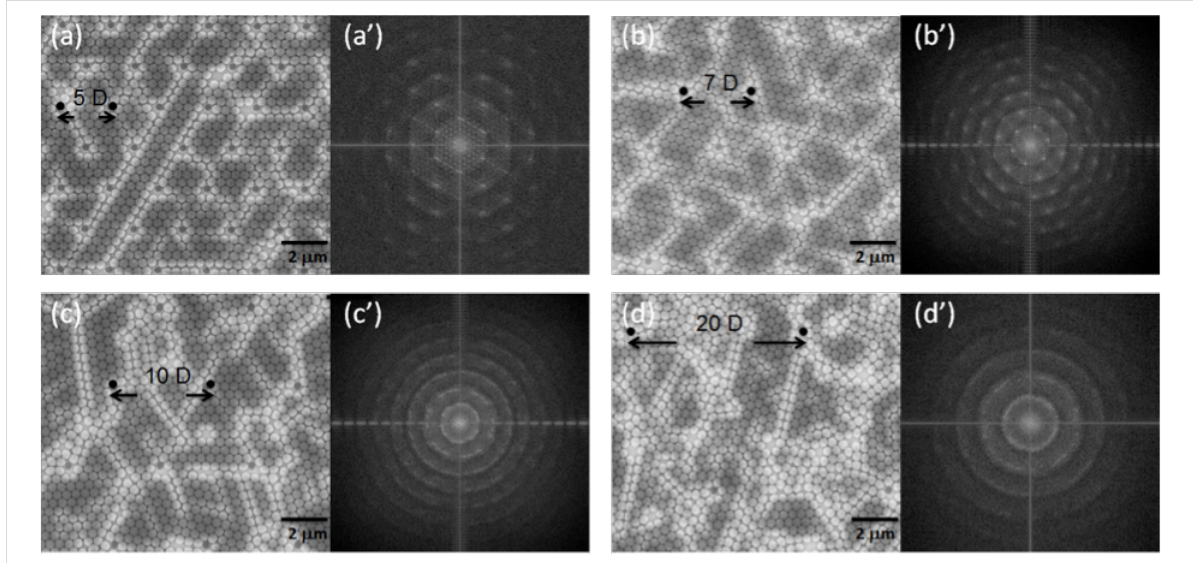
Figure 3: Influence of the pre-pattern pitch (post to post distance) with a fixed post diameter D = 390 nm. SEM images with P = (a) 5, (b) 7, (c) 10 and (d) 20 D, respectively. (a)’, (b’), (c’) and (d’) correspond to the 2D Fourier transforms of (a), (b), (c) and (d) images, respectively.